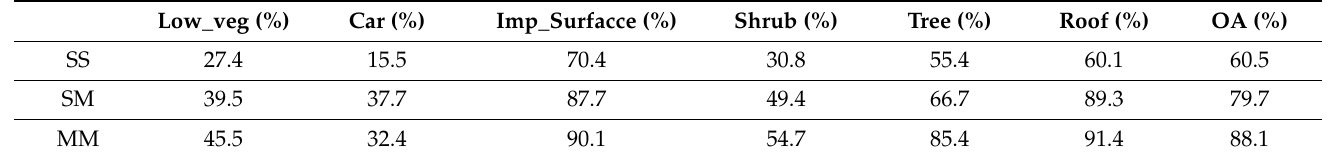
Table 4. Classification results and overall accuracy.